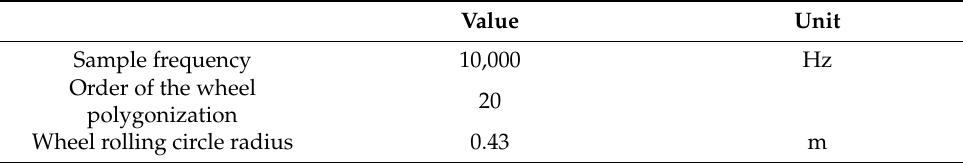
Table 3. Simulation